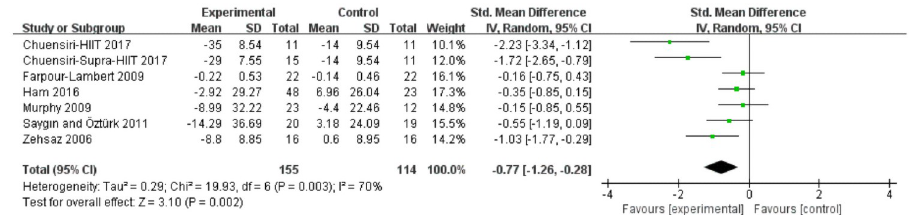
Fig 8. Forest plot of comparison: Total cholesterol.